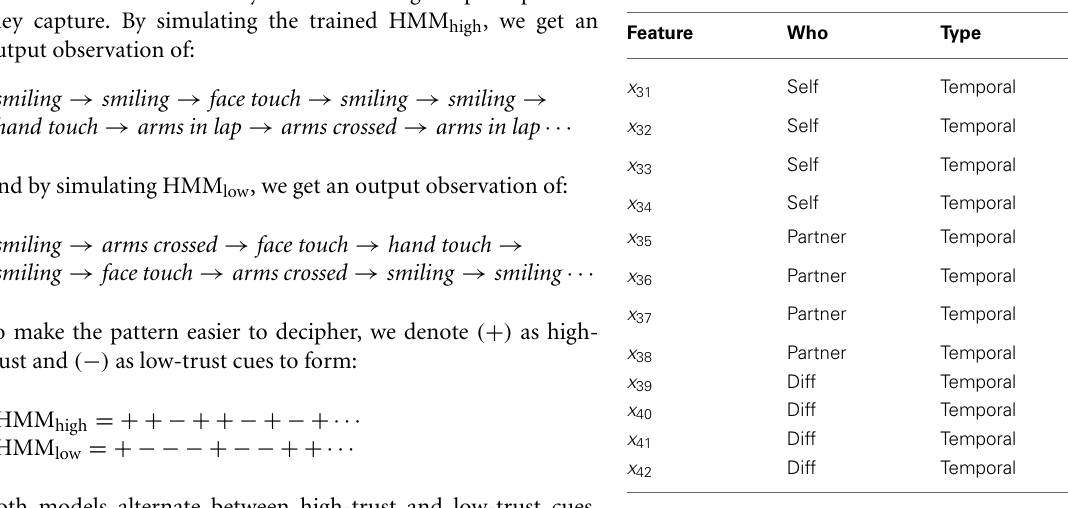
Table 4 | Twelve new features, consisting of the frequencies in which the low-trust templates are emitted by the participant, their partner, and the difference in frequency between them, used to train the final SVM model.